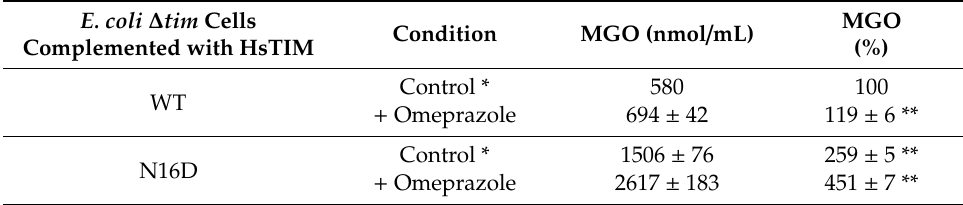
Table 3. Methylglyoxal (MGO) determination from E. coli ∆ tim cells complemented with WT and N16D